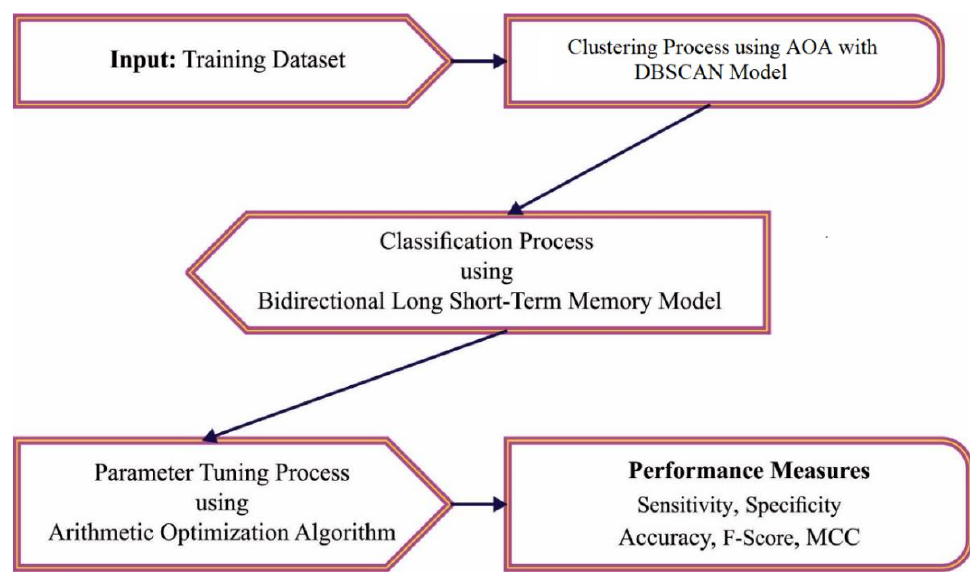
Figure 1. Overall process of AOEDBC-DL system.